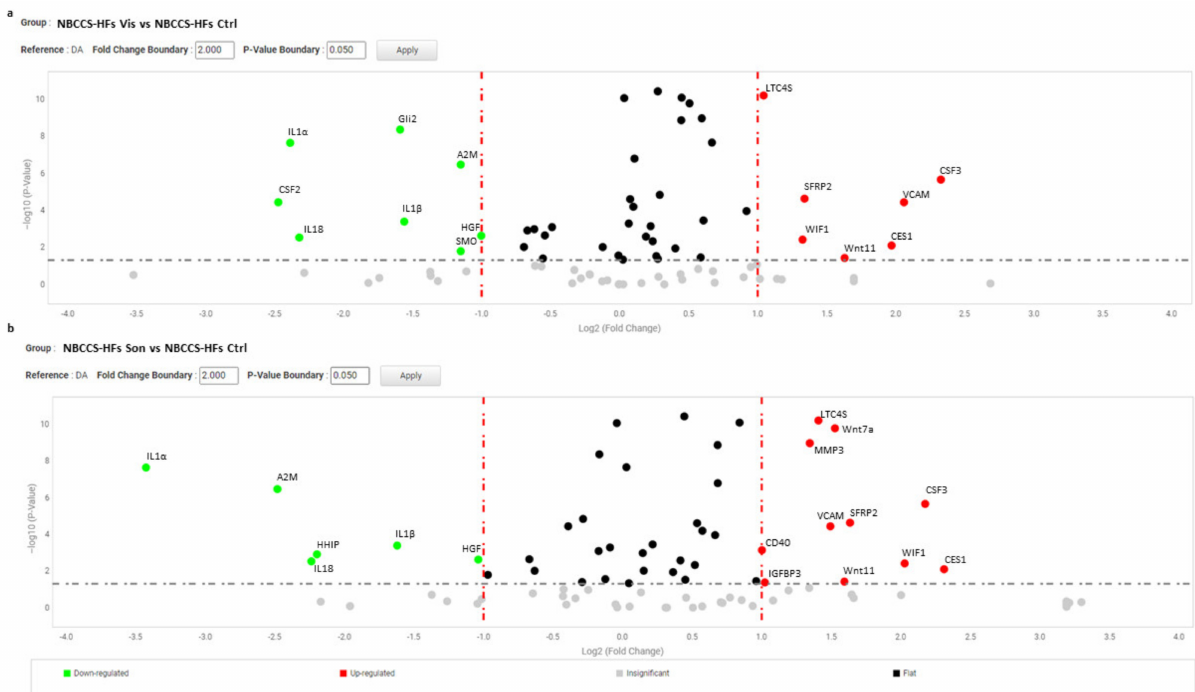
Figure 4. Volcano plot represents gene expression analysis comparing NBCCS-HFs treated with vismodegib ( a ) and sonidegib ( b ) for 72 h (n = 9) to NBCCS-HFs untreated (n = 9). (b) Analysis was performed using three different housekeeping genes ( β -actin, GAPDH and 18S). A one-way ANOVA statistical test with thresholds >2.0 fold-change and p < 0.05 defined significant increase are reported in red; significant decrease <0.5 fold-change and p < 0.05 reported in green; any fold- difference with p ≥ 0.5, e.g., insignificant are reported in grey; ≤ 2.0 or ≥ 0.5 difference e.g., flat reported in